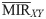
Results for the case of additional data for a pair of nodes with uniformly random, uncorrelated data.Panel (a) shows the estimation of τ ≈ 0.27 based on the ordered MIR¯XY values for a network of 6 isolated nodes without the introduction of the pair of nodes with uniformly random, uncorrelated data. Panel (b) is the unsuccessfully inferred network based on panel (a). Panel (c) shows the ordered MIR¯XY values for the same network with the nodes of random data added. The black bars are the MIR¯XY values that come from the pair of additional nodes. Panel (d) shows the resulting successfully inferred network of isolated, disconnected nodes. In panels (a) and (c), we plot τ by a red dash line where τ ≈ 0.27 in (a) and τ ≈ 0.5 in (c).